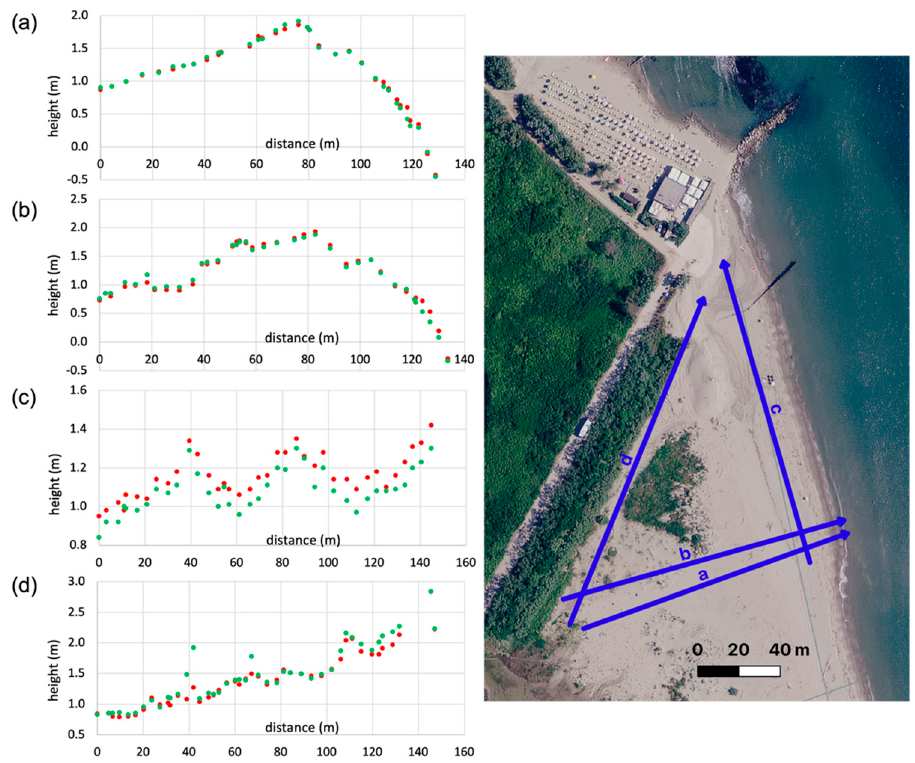
Figure 7. Examples of cross-shore ( a , b , d ) and along-shore ( c ) profiles of 2020 survey for GNSS (red) and UAV-derived (green) data.